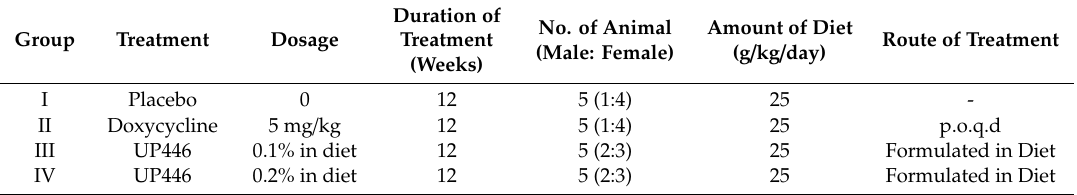
Table 1. Dosing of each treatment.